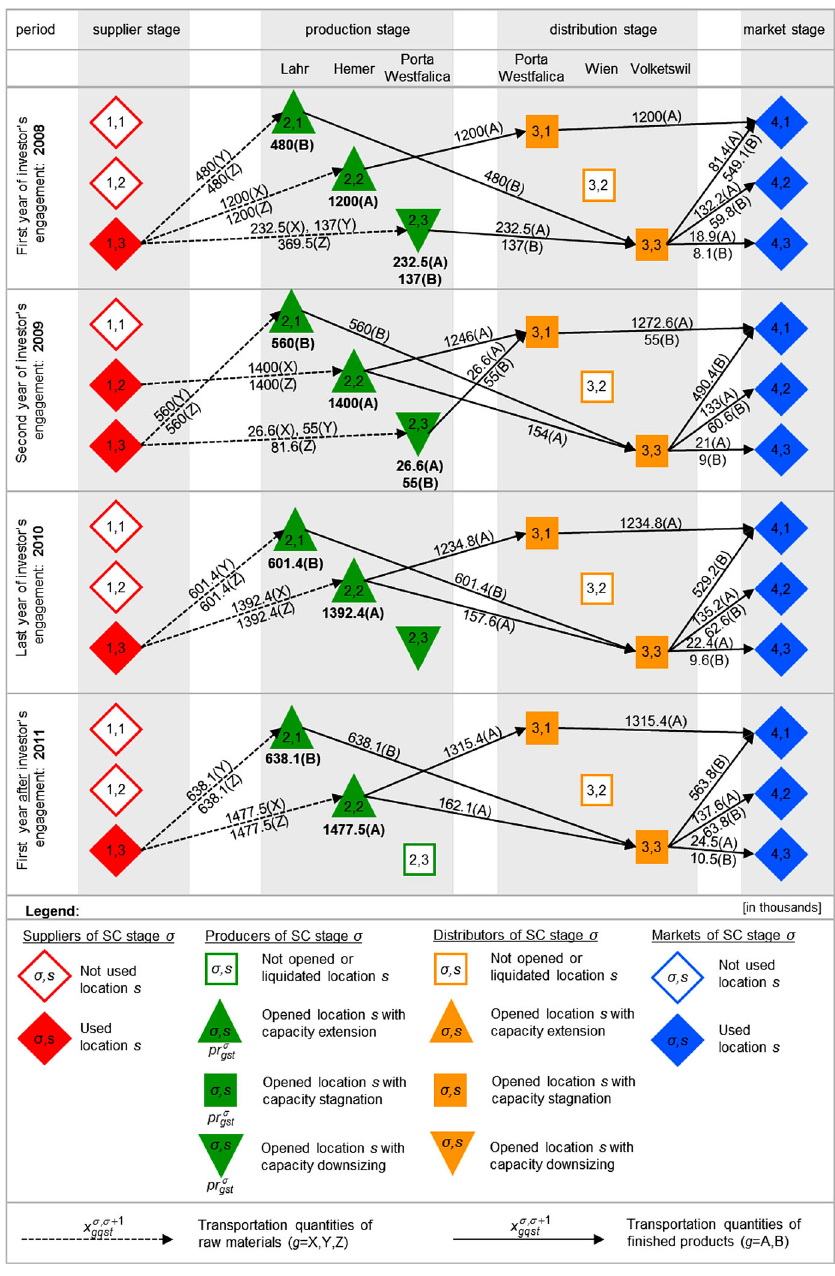
Fig. 4 Optimal supply chain network